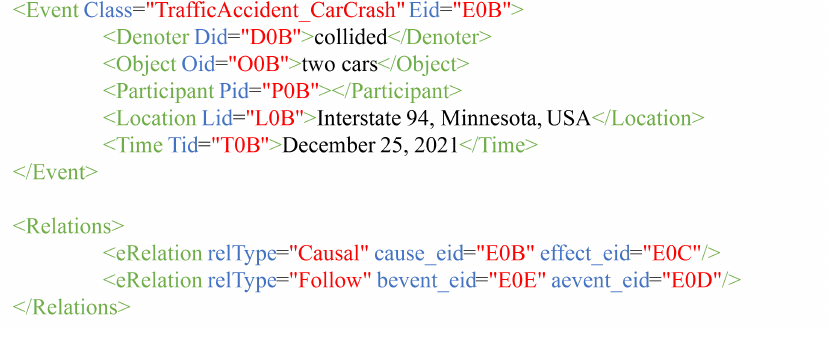
Figure 3. Data annotation